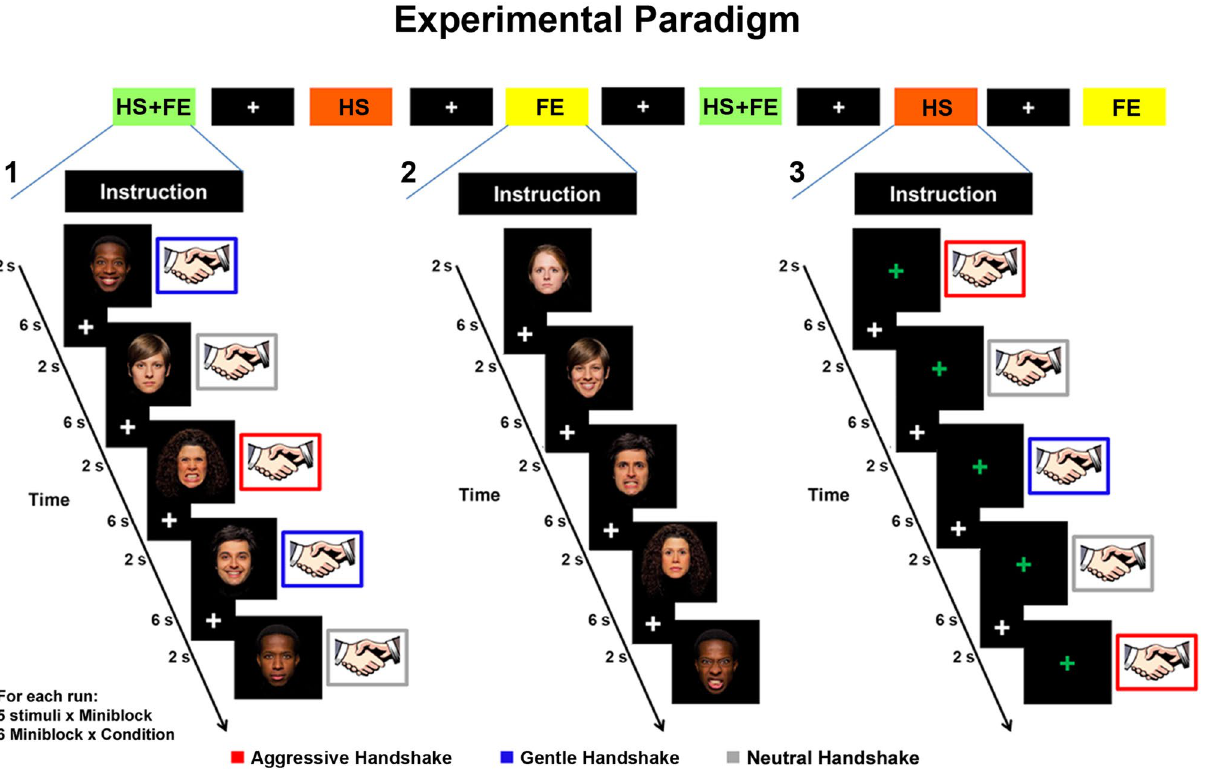
Figure 2. Experimental paradigm adopted in the experiment 1. Three different situations were presented [handshake and facial expression, HS + FE (1); facial expression, FE (2); handshake, HS (3)]. Each video stimulus was presented as a single event lasting 2 s in miniblocks composed of five stimuli intermixed with an inter stimulus interval lasting 6 s. During handshake and facial expression (HS + FE) and facial expressions (FE) situations, a total of 15 facial expressions were presented: 10 for the vitality condition (5 actors × 2 facial expressions) and 5 for the control condition (5 neutral expressions). Facial expressions were freely shared by https:// appre cs. com/ ios/ 41501 1116/ volaf riends. During the observation of happy, angry and neutral facial expressions, participants received a congruent handshake (gentle, blue color; aggressive, red color; neutral, gray color). During the handshake situation (3), participants received a gentle (blue color), aggressive (red color) and neutral (gray color) handshake. The same paradigm was also adopted in experiment 2 but during the observation of happy, angry, neutral facial expressions, participants received always a neutral handshake (for details see Figure